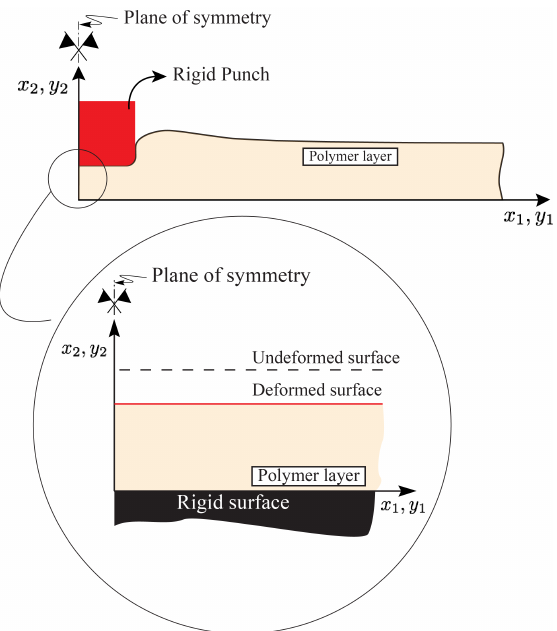
Figure 2. A schematic of an infinitely long elastomeric layer compressed by a finite flat punch. The schematic corresponding to the uniform compression can be seen as a close-up view of the indentation model in the vicinity of the symmetry